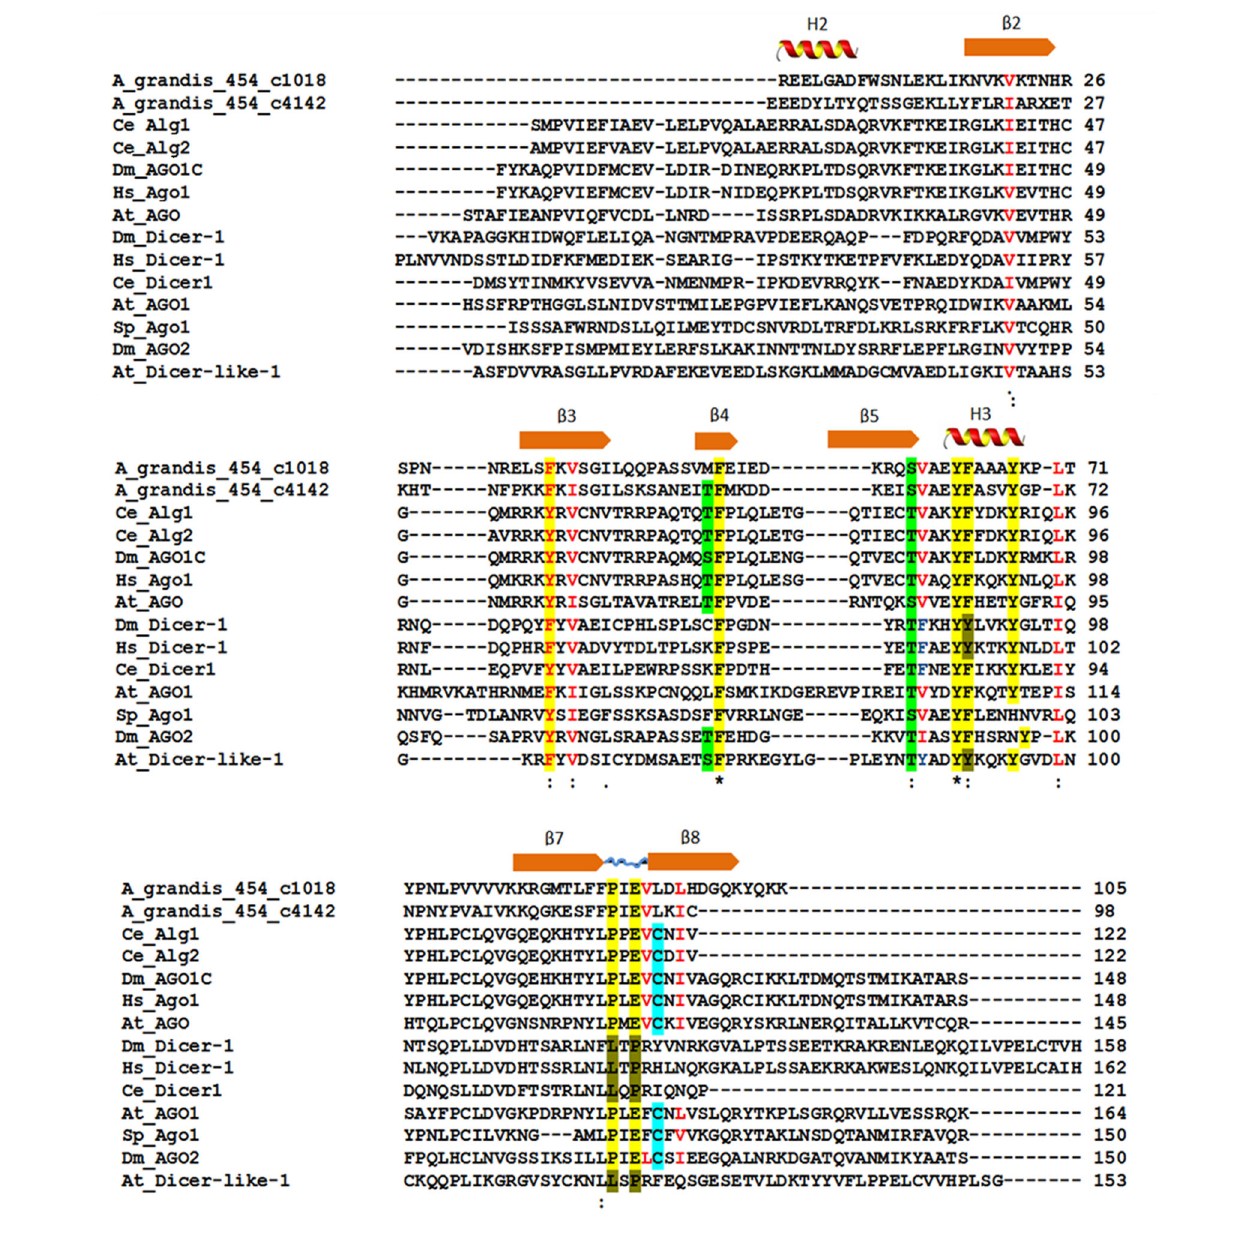
Figure 7. Comparison of dicer and argonaute PAZ domains. Two cotton boll weevil contigs were aligned to five species sequences: D. melanogaster (Dm_Dicer-1, Dm_AGO1C, Dm_AGO2) , C. elegans (Ce_Dicer1, Ce_Alg1, Ce_Alg2) , Homo sapiens (Hs_Dicer-1, Hs_Ago1) , A. thaliana (At_Dicer-like-1, At_AGO, At_AGO1) and Schizosaccharomyces pombe (Sp_AGO1). The sequence IDs are the same found in the NCBI Protein Database. Secondary structures within the domain are indicated as α-helices and β structures. The highlighted residues are responsible for the stabilization of the dsRNA-binding region. In yellow, a subdomain of aromatic residues. Along with a cysteine residue (blue), preceded by a proline and a glutamate (yellow), some invariant residues (red) create a hydrophobic subdomain that interacts with RNA. Residues that differ in dicer and argonaute PAZ domains are shown in